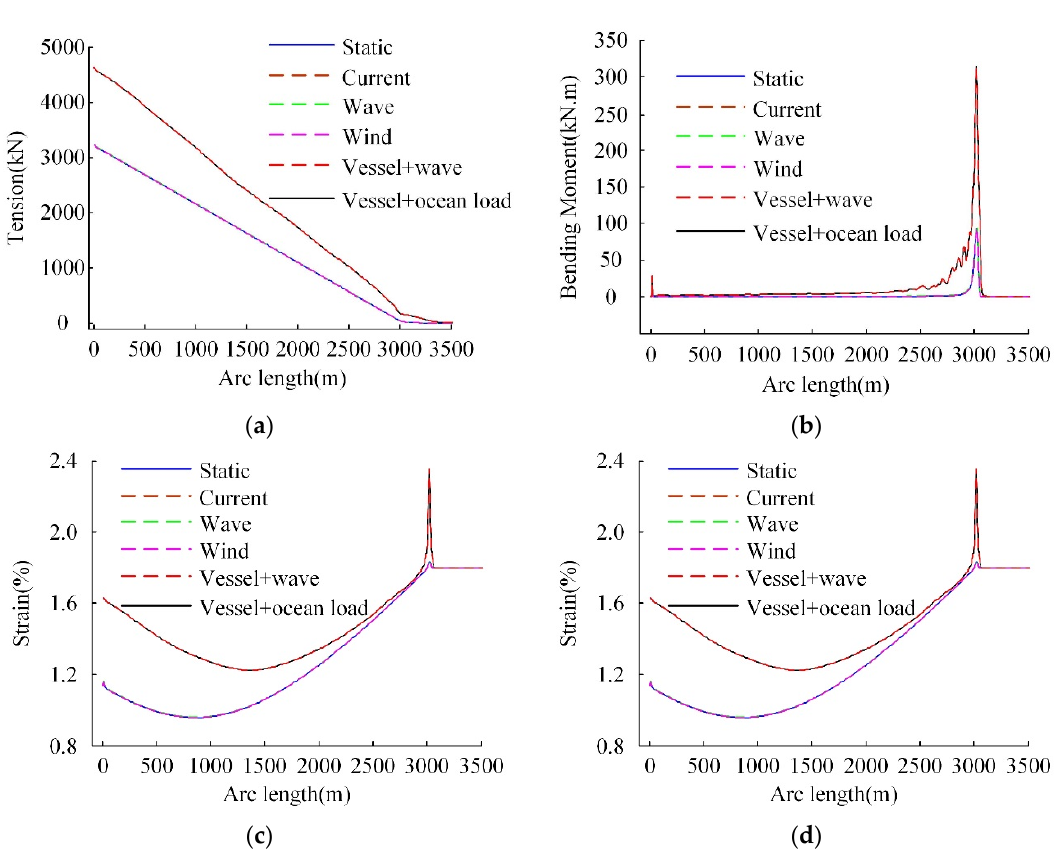
Figure 9. Effect of different factors on pipeline dynamic responses: ( a ) Axial tension; ( b ) Bending moment; ( c ) Strain; ( d ) Stress.